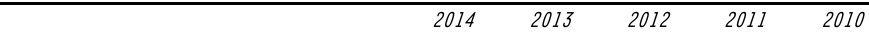
TABLE 14: Shoprite sustainability frequencies from 2010 to